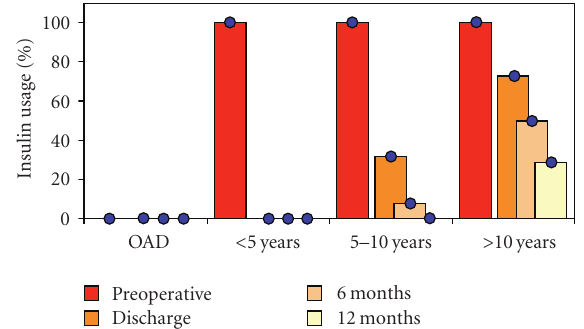
Figure 4: Reduction of insulin usage after BPD-DS dependent on preoperative duration of insulin usage. Group I “OAD” was treated by oral antidiabetic drugs only and used no insulin postoperatively. Group II used insulin for less than 5 years preoperatively and needed no insulin at discharge and after. Group III used insulin for 5 to 10 years. Thirty-seven percent of patients in this group needed insulin at discharge (light brown bar), but all patients in this group were free of insulin 1 year after the operation. Group IV used insulin for more than 10 years. Seventy-three percent of patients in this group needed insuline at discharge (light brown bar), 23% of patients in this group still needed insuline 1 year after the operation (white bar).